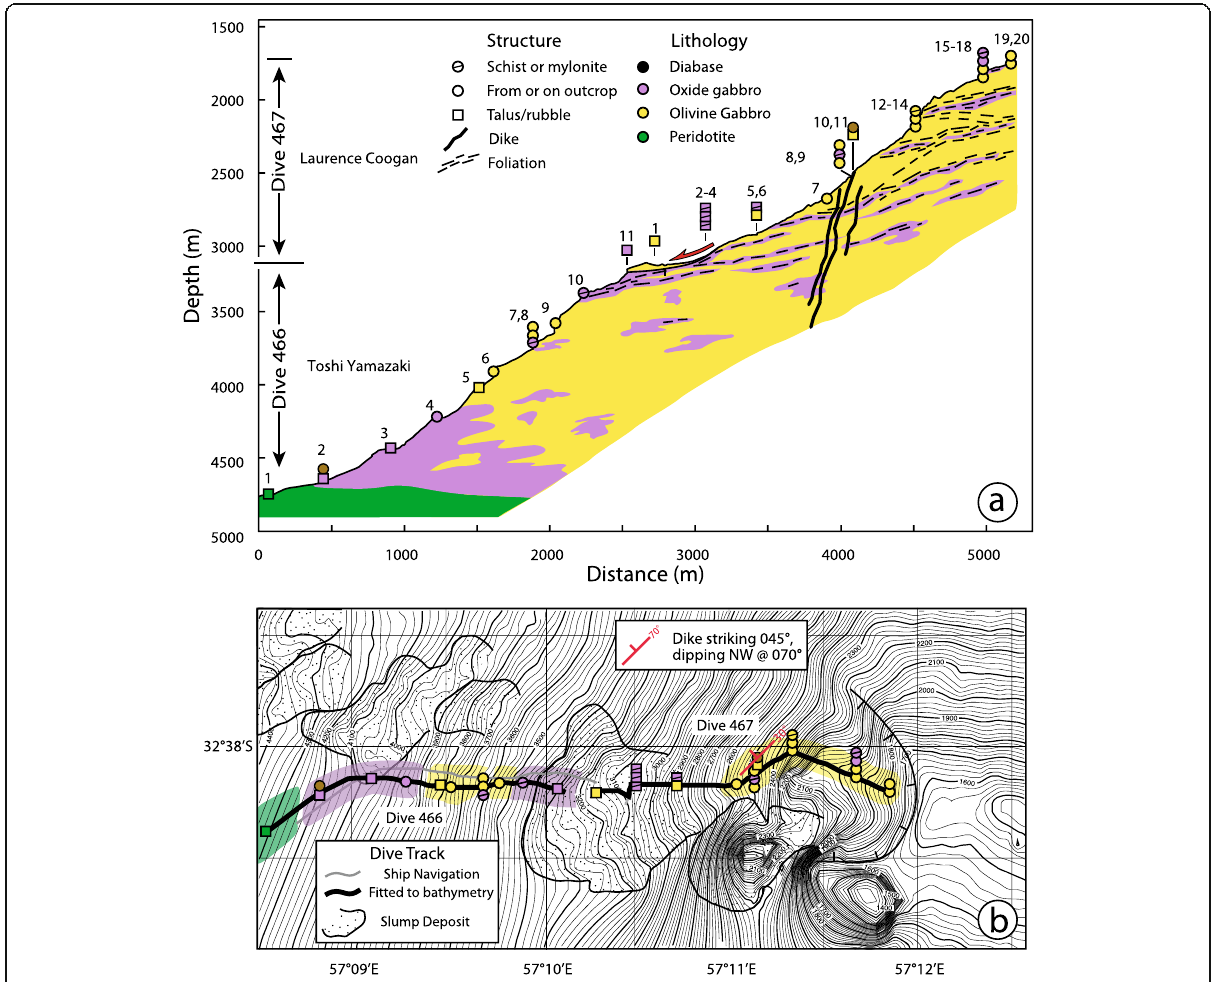
Fig. 24 Geologic interpretations of the Dive 466 and 467 traverses (Fig. 3) up the transform wall bounding the main gabbro massif ~ 4 km south of its northern limit. a Dive profile with the geologic interpretation (1:1 section). Shear sense on fault indicated by the red arrows. b Plan view of the track on surface bathymetry collected during Mode 98. The combined traverses extend from below the gabbro-mantle contact near the base of the transform wall to ~ 250 m below the primary detachment fault surface. Toshi Yamazaki and Laurence Coogan diving scientists as indicated in a . Note that dikes are illustrated as perpendicular to the dive profiles, rather than their true orientation, which in most case is ~